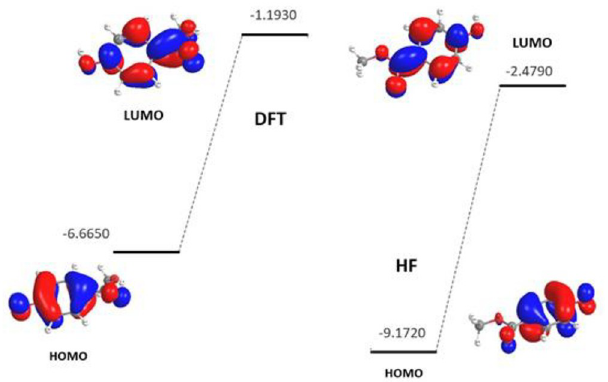
Fig 5. Calculated 3D of HOMOs-LUMOs plots and their energies (eV) of the compound by HF and DFT/B3LYP with 6-311G(d,p).